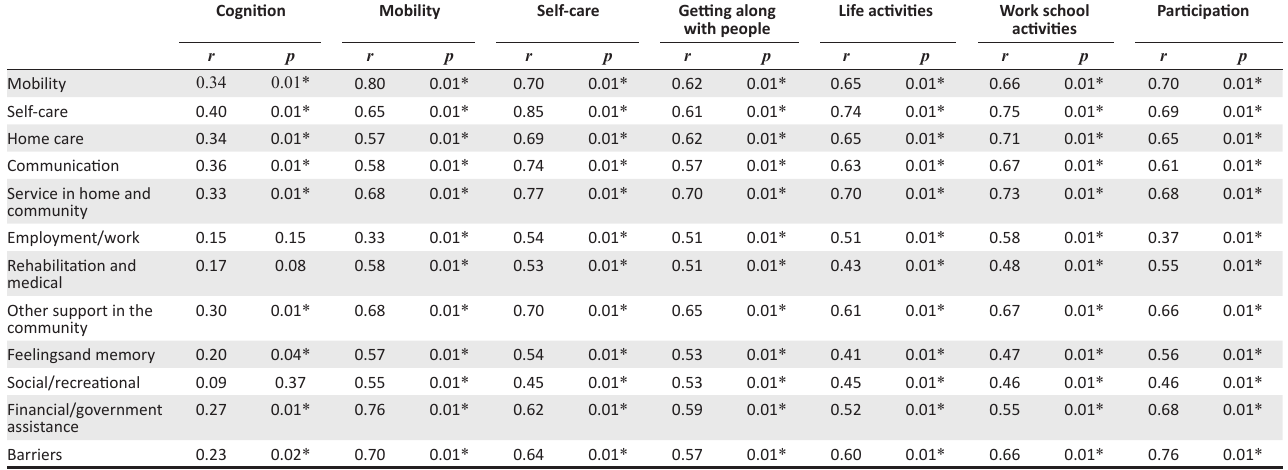
TABLE 5: Relationship between expressed rehabilitation needs (as scored by modified Needs Assessment Questionnaire) and domains of disability (as scored by World Health Organization disability assessment schedule 2.0 ( n = 105)). Cognition Mobility Self-care Getting along with